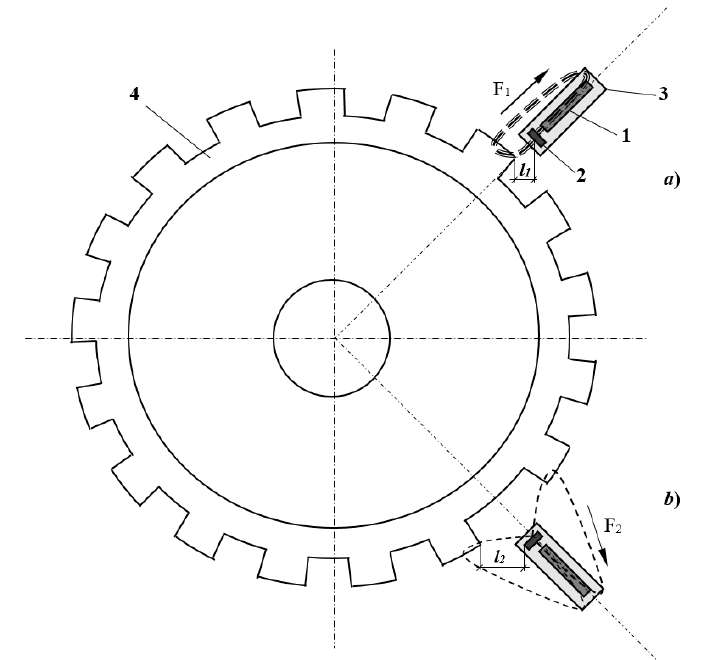
Figure 5. Principle of the operation of the ME CKP. ( a ) ME sensor is located above the tooth; ( b ) ME sensor is located between the teeth in the